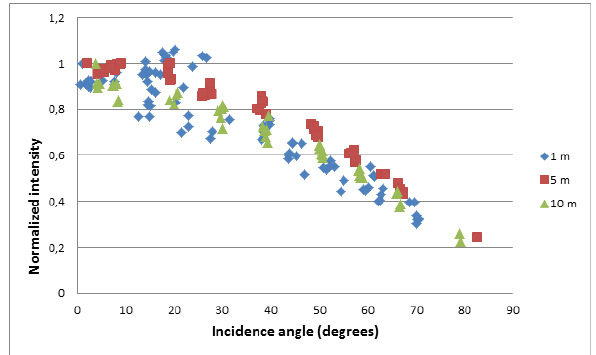
Figure 9. Comparison of the incidence angle effect of the 50 % reflectance Spectralon panel when distance effect has been corrected from the intensity data. Distances of 1, 5 and 10 meters are compared. The intensity is normalized to 1 at 0 ⁰